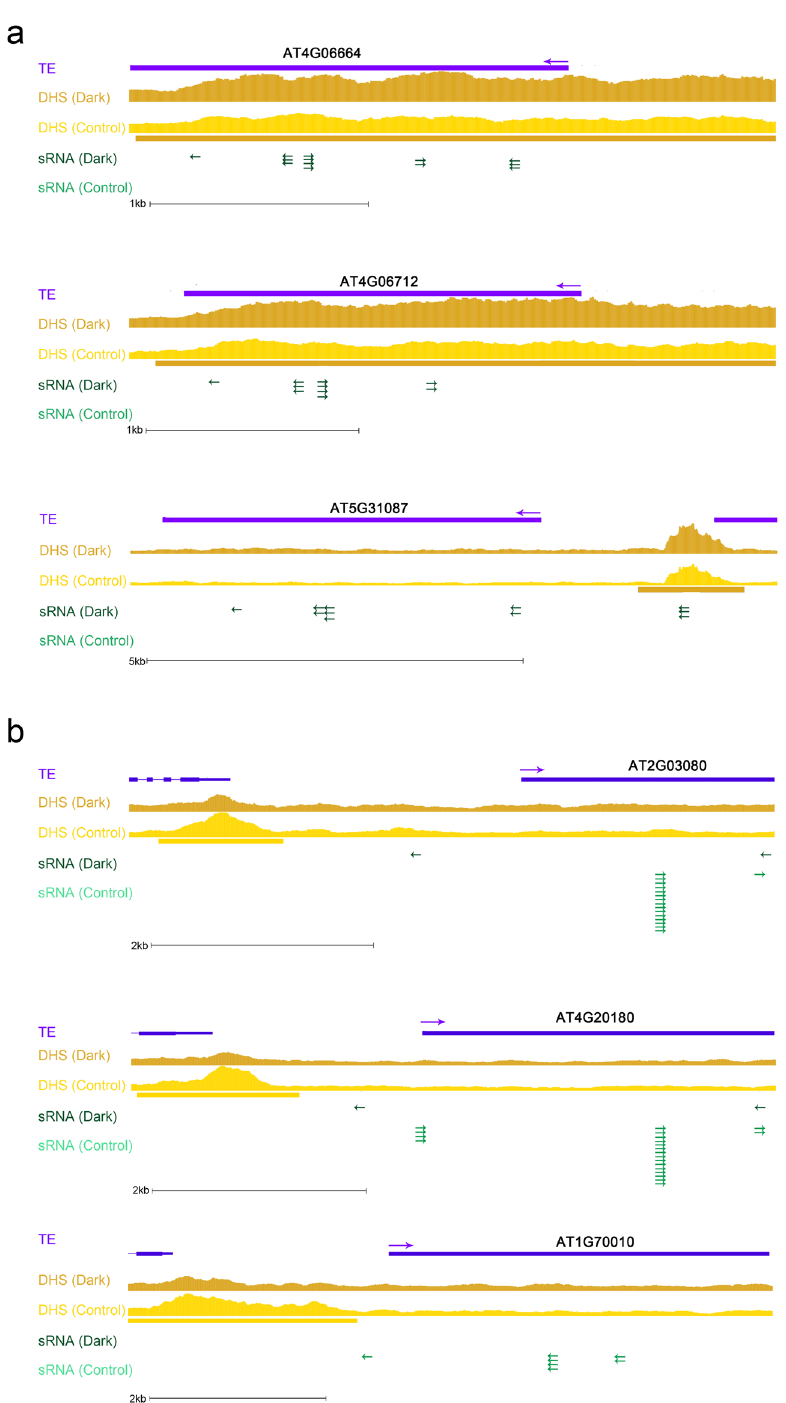
Figure 5. Selected TEs associated with DHSs and mapped siRNA reads in the UCSC genome browser. The gene models are shown in purple, with the direction marked by an arrow. The brown and yellow colors represent that DHS signals under extended darkness and control condition, respectively. The DHS-increased region is marked by a brown bar, and the DHS-diminished region is marked by a yellow bar. The dark and light green colors represent siRNA reads. The direction of mapping is marked by an arrow. ( a ) siRNA-increased Gypsy-like TEs. ( b ) siRNA-decreased Copia-like